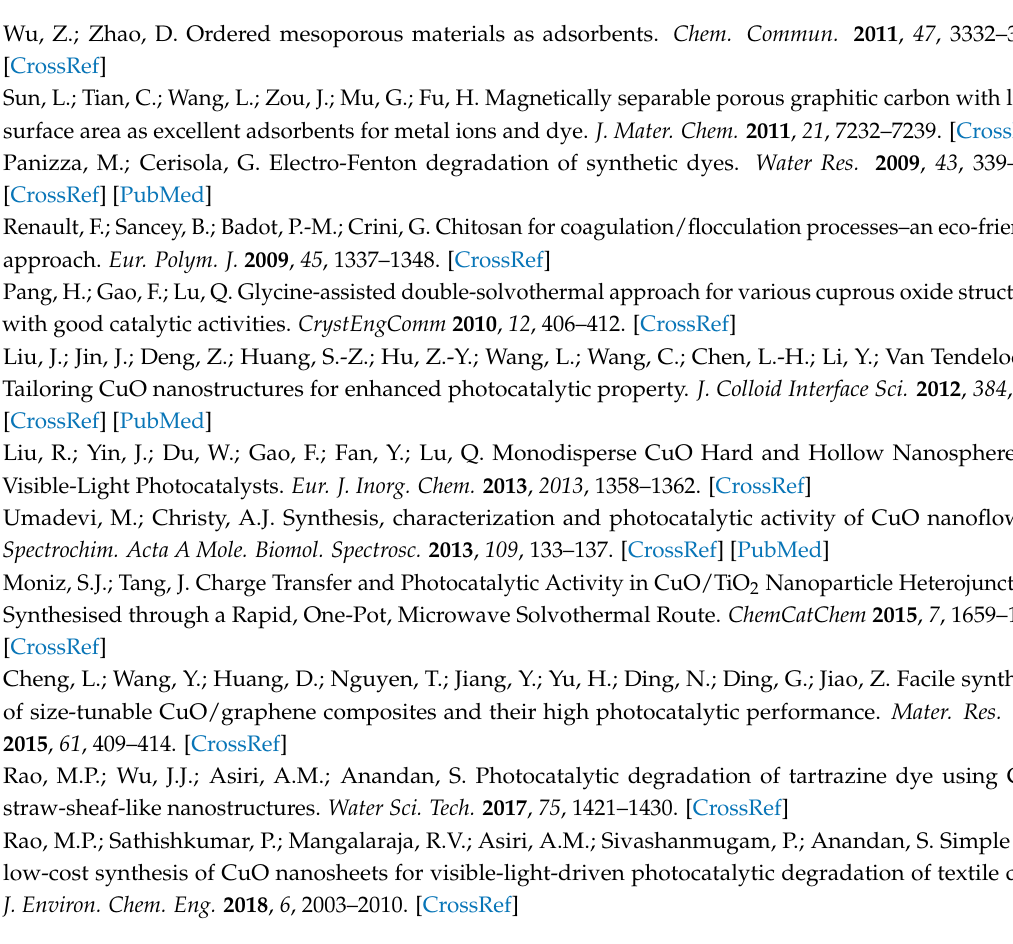
s1, Figure S1: (a) Nitrogen adsorption-desorption isotherms and (b) corresponding pore size distribution curve of the CuO-CuS nanowires, Table S1: BET surface area and pore size of the CuO-CuS nanowires, Figure S2: UV-Vis absorbance spectra for cycling degradation of MB aqueous solutions by CuO-CuS nanowires. Author Contributions: Y.-T.K. and K.-C.L. conceived the study and designed the research. Y.-T.K. and S.-M.Y. conducted the experiments. Y.-T.K., S.-M.Y. and K.-C.L. wrote the manuscript. All authors read and approved the final